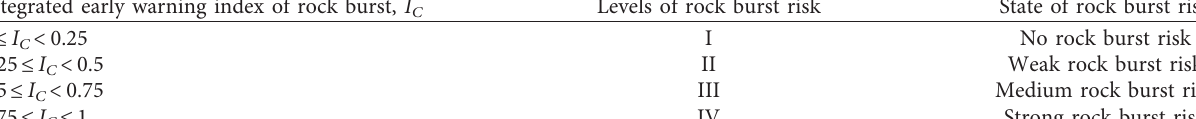
Table 2: Rock burst hazard classification.